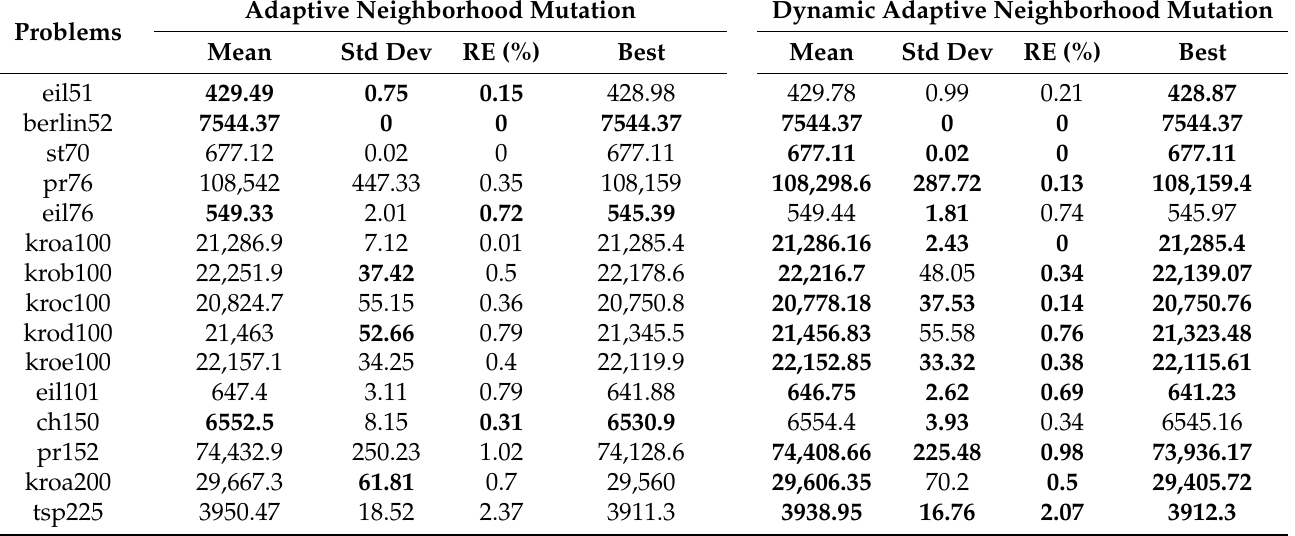
Table 3. Comparisons with adaptive neighborhood mutation and dynamic adaptive neighborhood